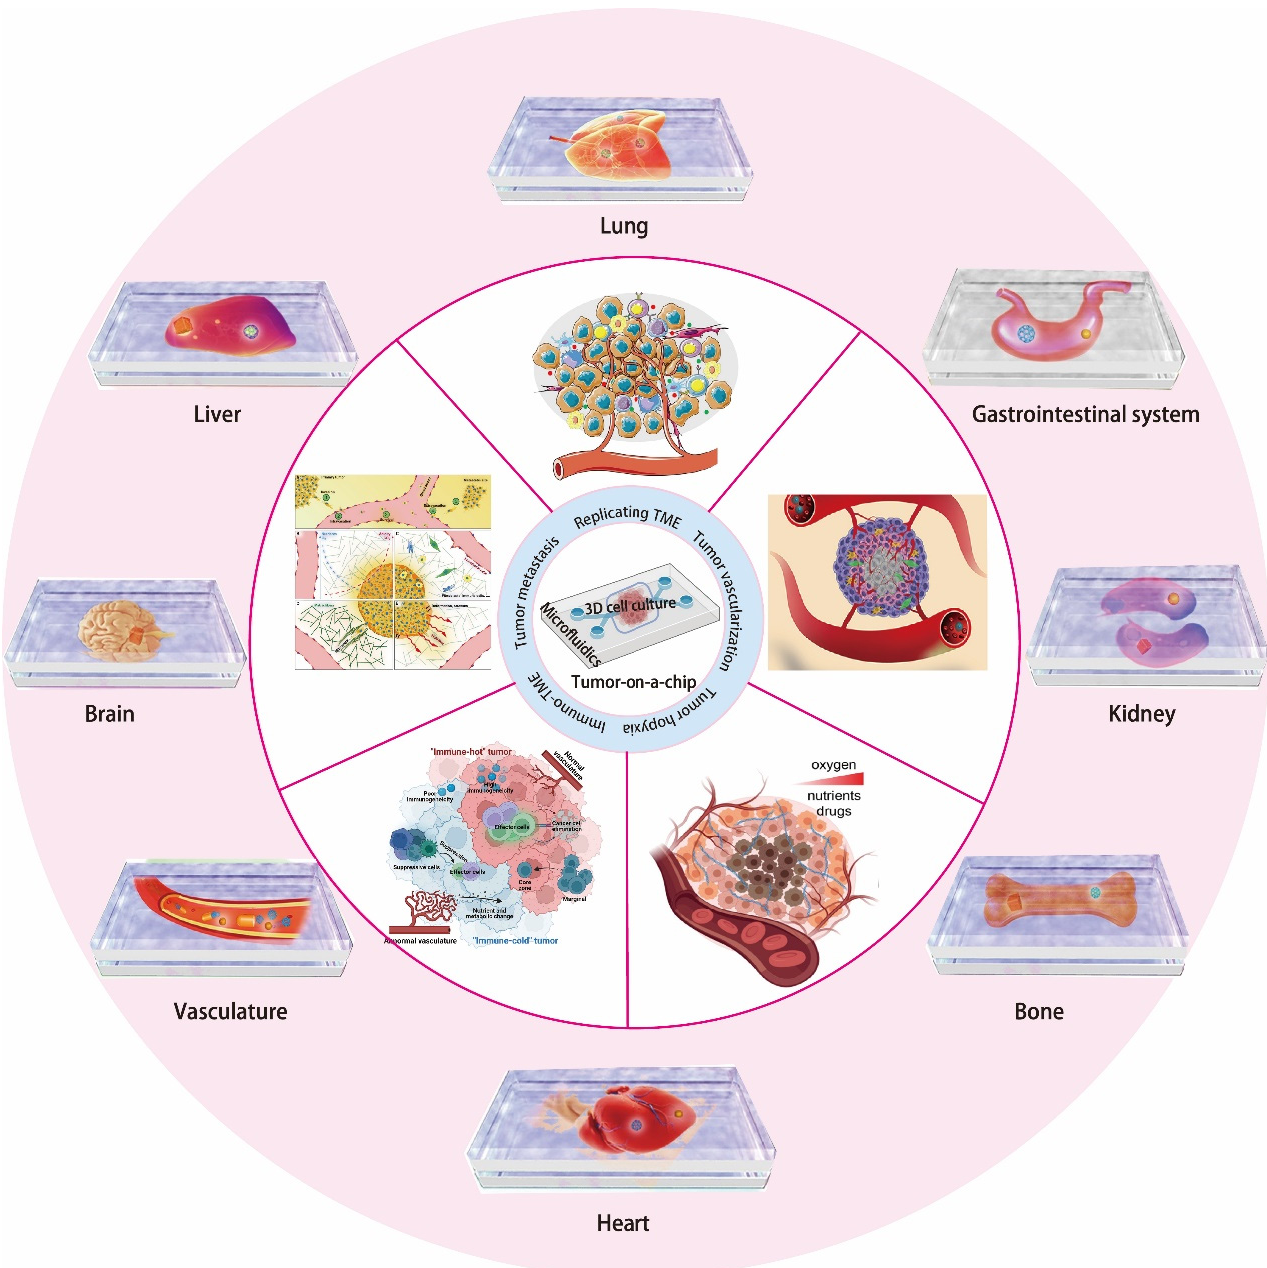
Figure 1. Schematic of OoC platforms for mimicking the TME and functions in vitro and their applications of reconstructing the organs on microfluidics for oncology studying.